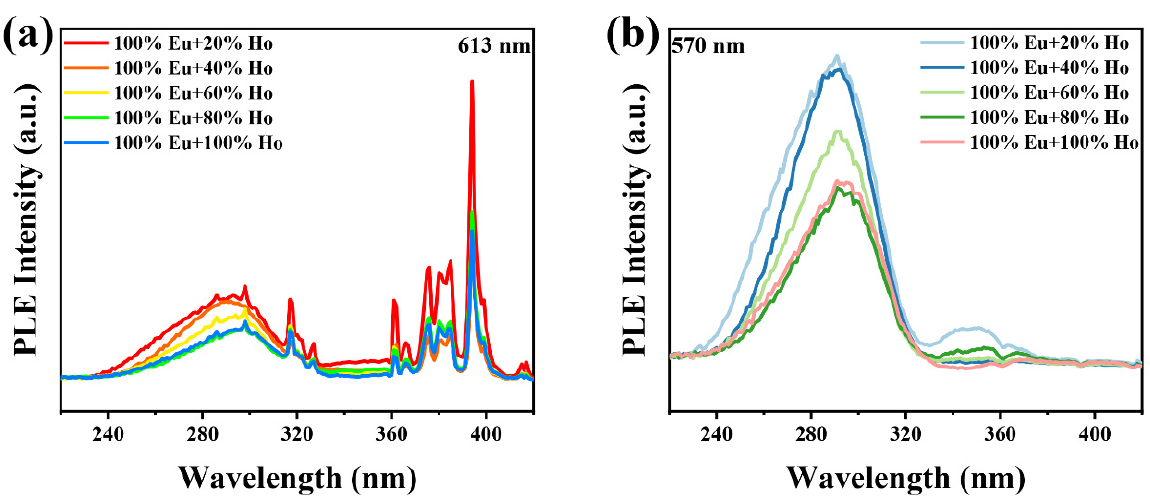
3+ /Eu 3+ /Ho 3+ ( a ) λ em = 613 nm ( b ) λ em = 570 2 Ag 0.3 Na 0.7 InCl 6 : Yb